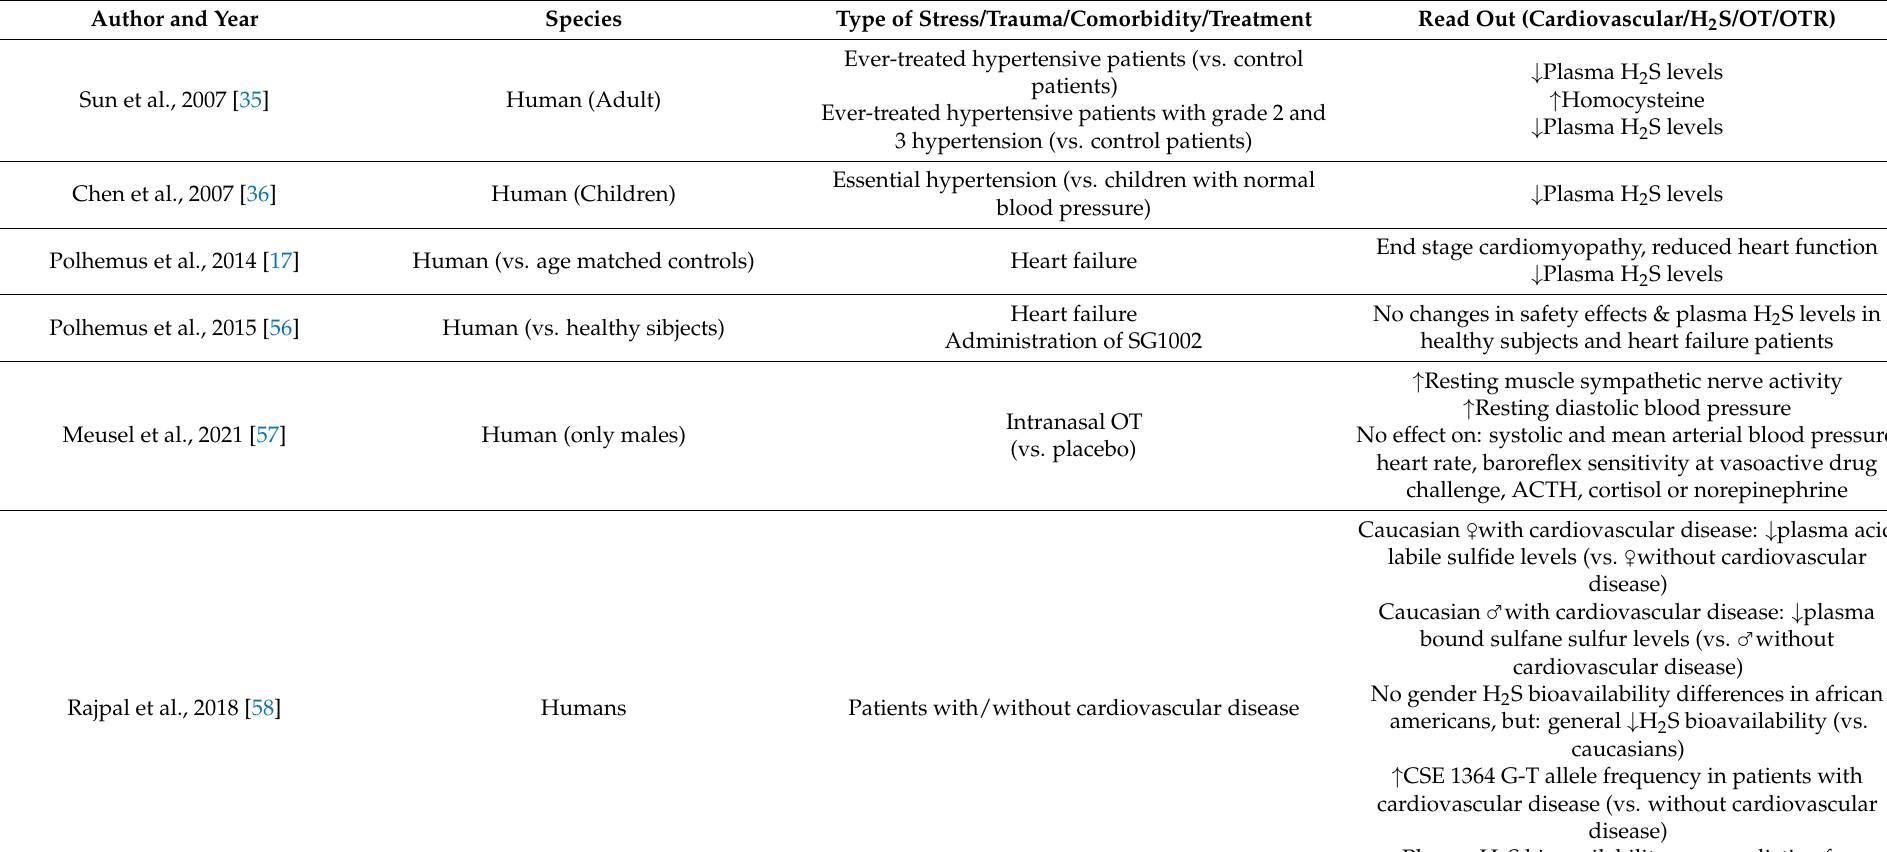
Table 2. Summary of human studies: effects of stress/trauma/comorbidity and treatment on the cardiovascular system, H 2 S system and OT/OTR